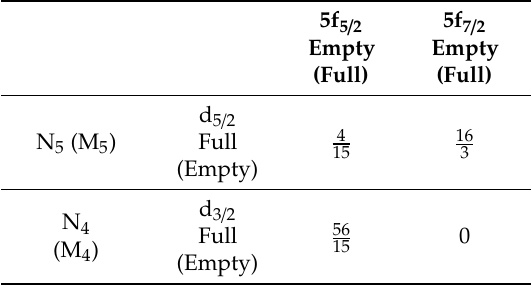
Table 1. Shown here are the relative 5f electric dipole cross sections. See Ref. [30] for details. Note that the relative 5f cross section total = 28 /